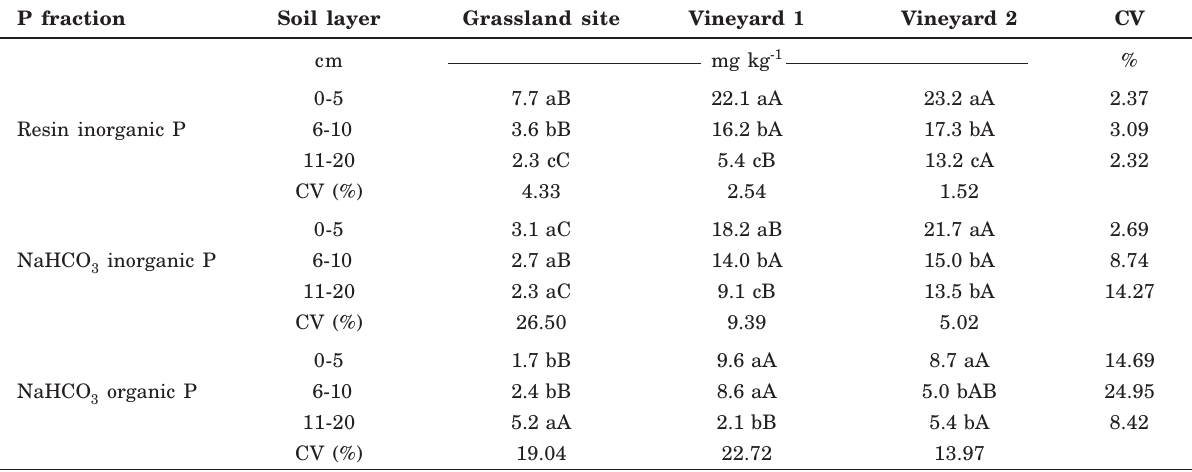
Table 2. Resin inorganic P, NaHCO 3 inorganic P and NaHCO 3 organic P fractions in a sandy Typic Hapludalf soil at a grassland site, vineyard 1 (age 14 years) and vineyard 2 (age 30 years), in three